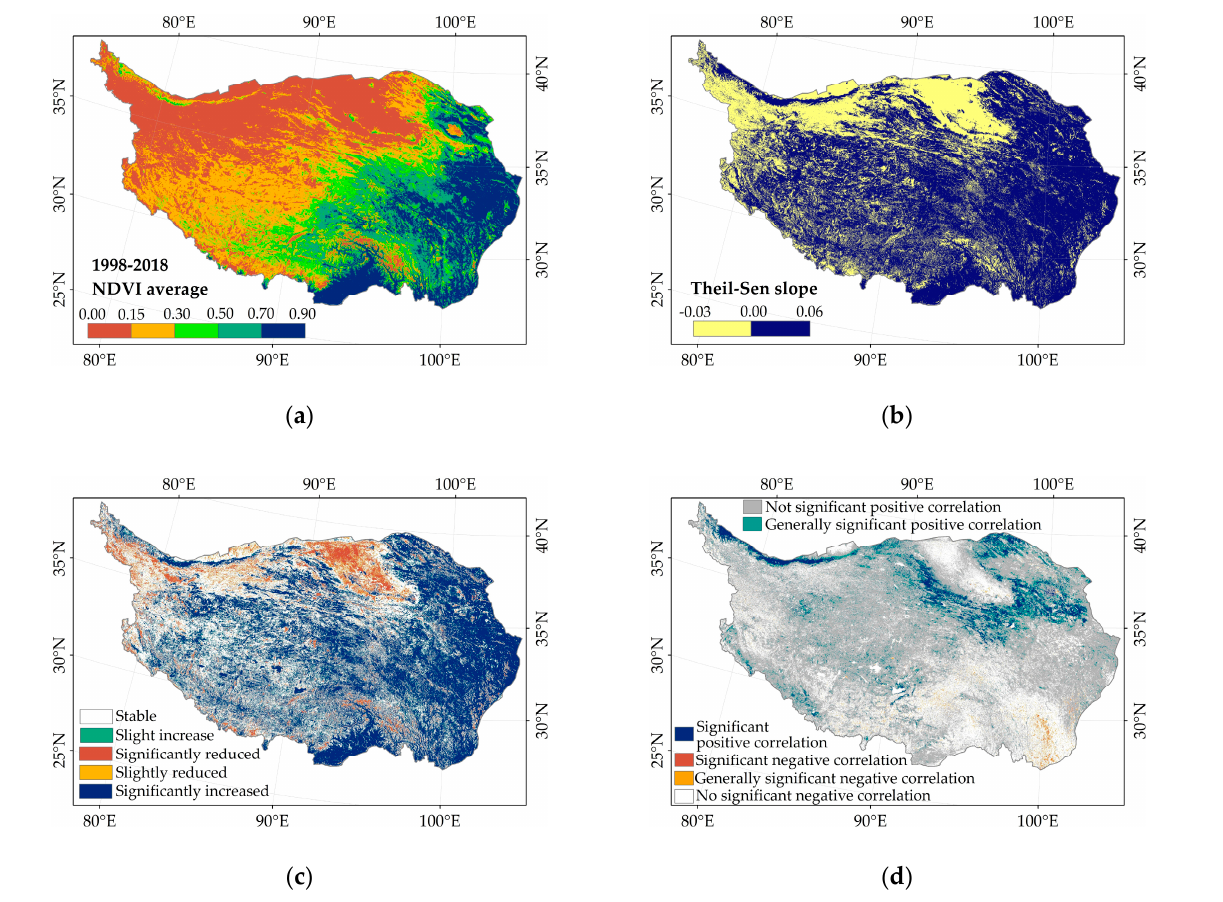
Figure 9. The spatial distribution and change trend of the NDVI from 1998 to 2018 and its correlation with precipitation: